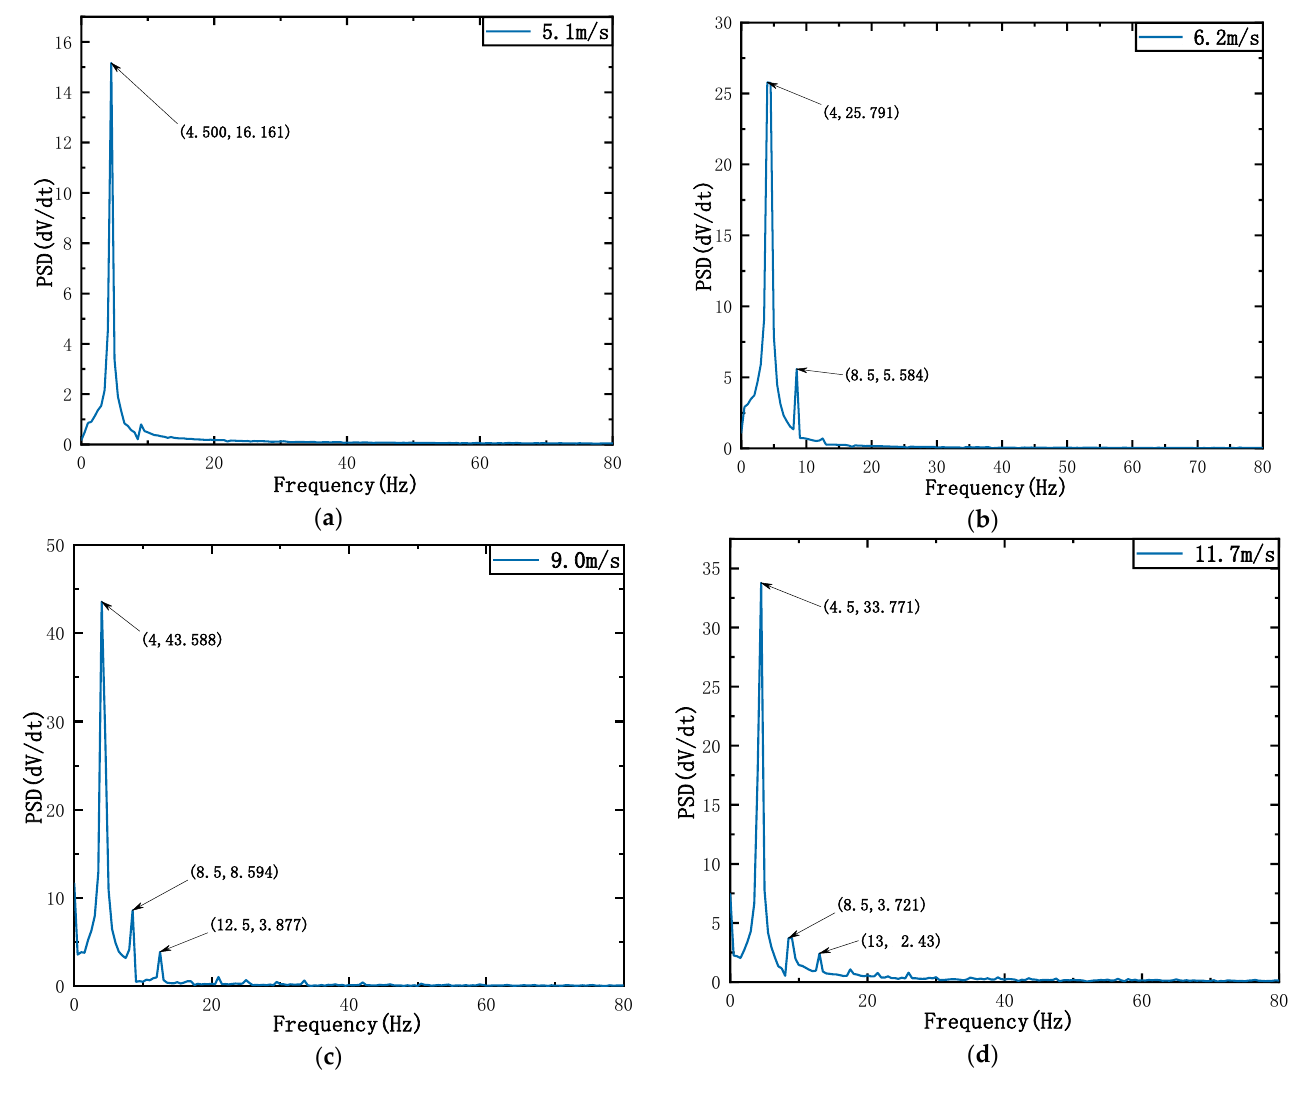
Figure 12. Power spectral density (PSD) plot of the VFPEH-30 at different wind velocities: ( a ) 5.1 m/s; ( b ) 6.2 m/s; ( c ) 9.0 m/s; ( d ) 11.7 m/s. ( b ) 6.2 m/s; ( c ) 9.0 m/s; ( d ) 11.7